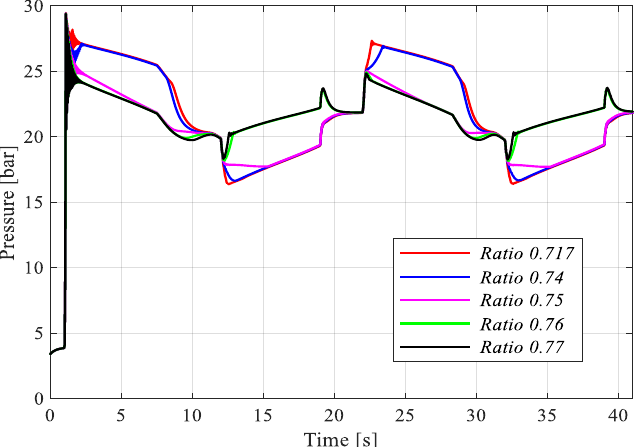
Figure 16. Pressure in the piston head chamber for different displacement ratios. Cracking pressure = 5 bar.